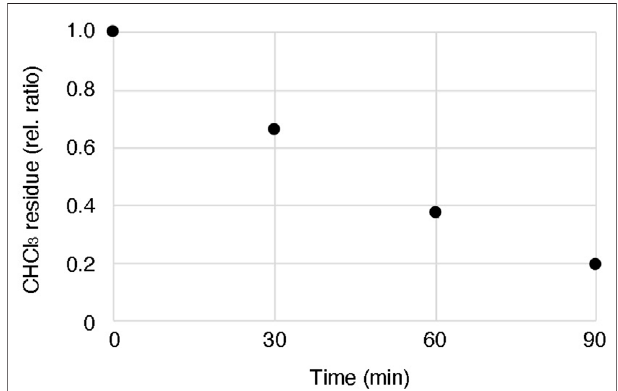
FIGURE 4 | Residual chloroform in oil after heating and stirring. 200 µL chloroform containing 100 mM lipid (POPC 50 mol%: POPG 50 mol%) was added into 1 ml mineral oil, and then the lipid-oil mixture was heated at 60 ° C with stirring. The weight of the mixture was measured every 30 min until 90 min. The data were based on three independent replicates of the